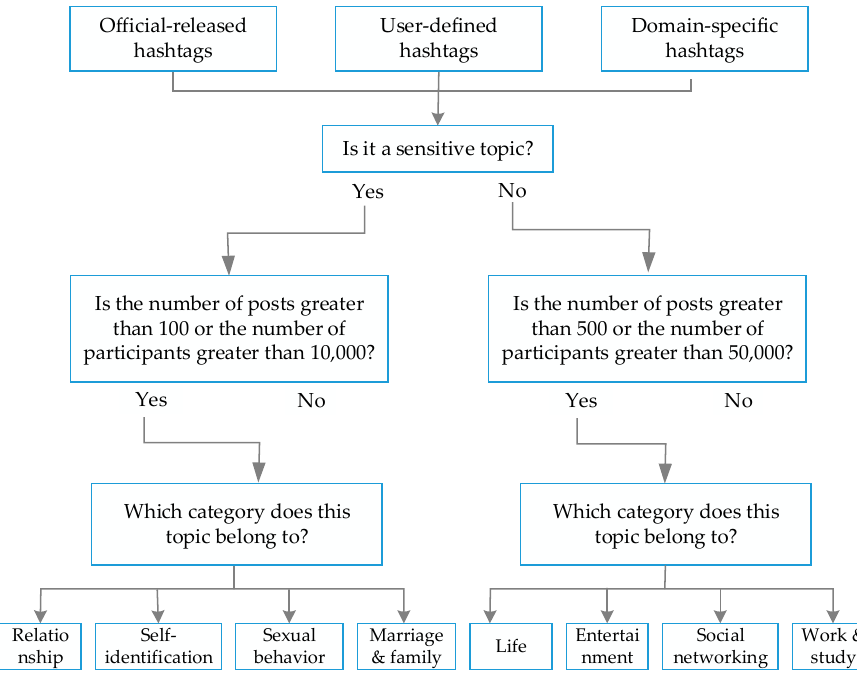
Figure 1. Flow of topic collection, filtering, and classification.